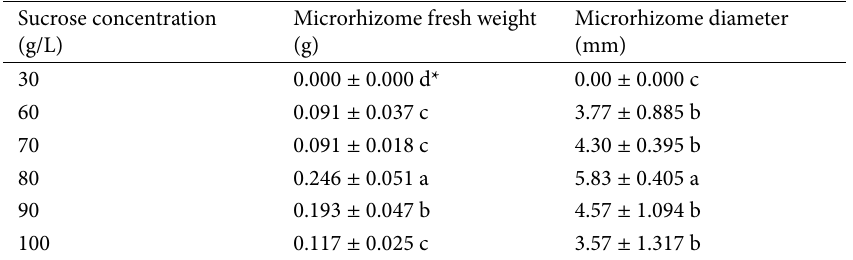
Table 1 Effect of sucrose concentrations on microrhizome